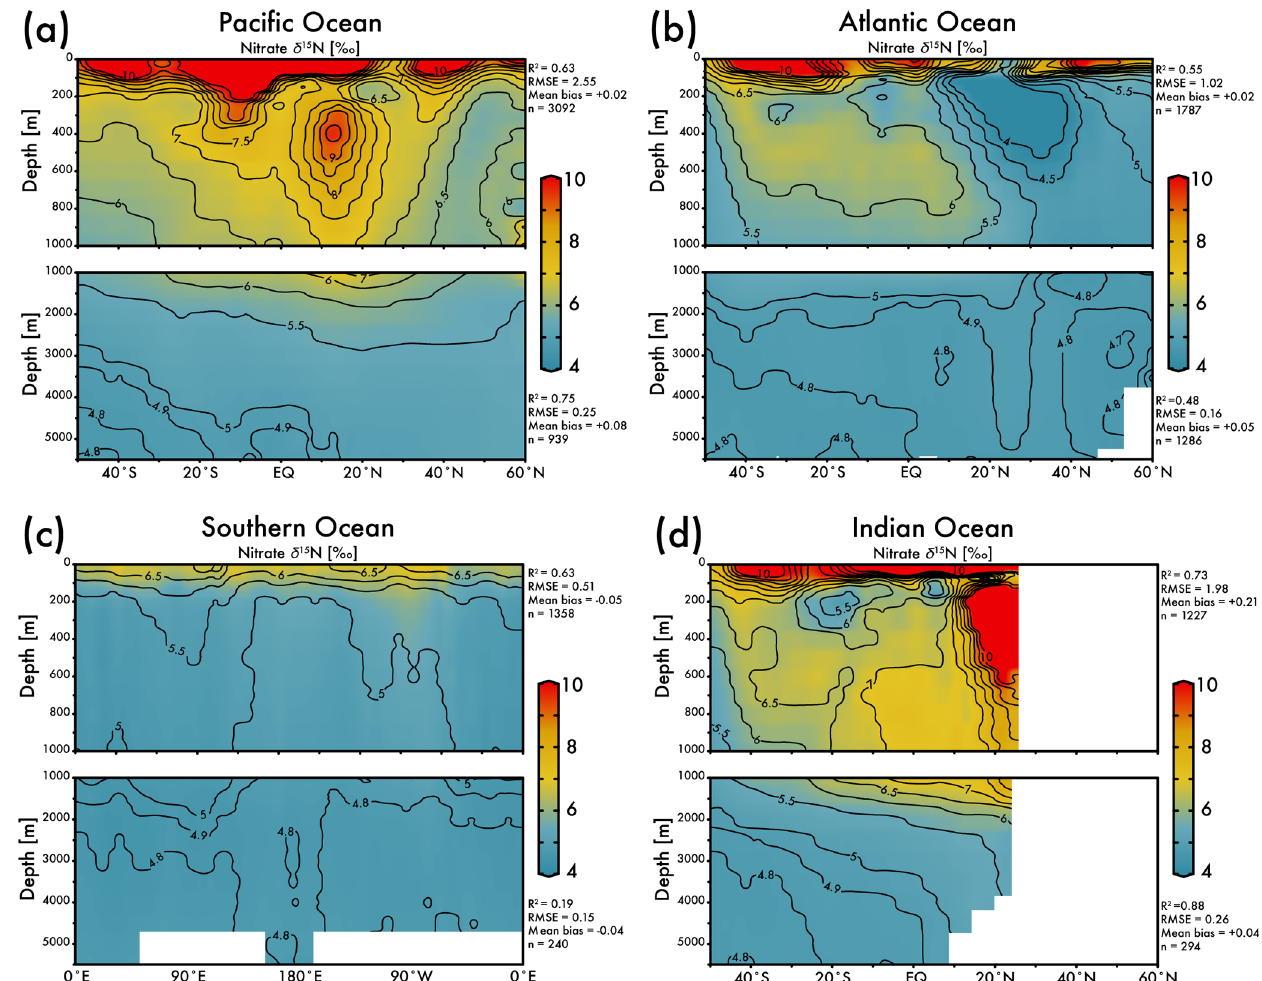
Figure 4. Zonal average of model nitrate δ 15 N versus latitude or longitude for the (a) Pacific Ocean, (b) Atlantic Ocean, (c) Southern Ocean, and the (d) Indian Ocean. White bars indicate no data because of land. The R 2 , RMSE, mean bias, and total number ( n ) of observed versus EANN nitrate δ 15 N are shown on the right for each region and depth range. White indicates regions of no data coverage. Note that these zonally averaged views obscure zonal gradients in nitrate δ 15 N (see Fig.